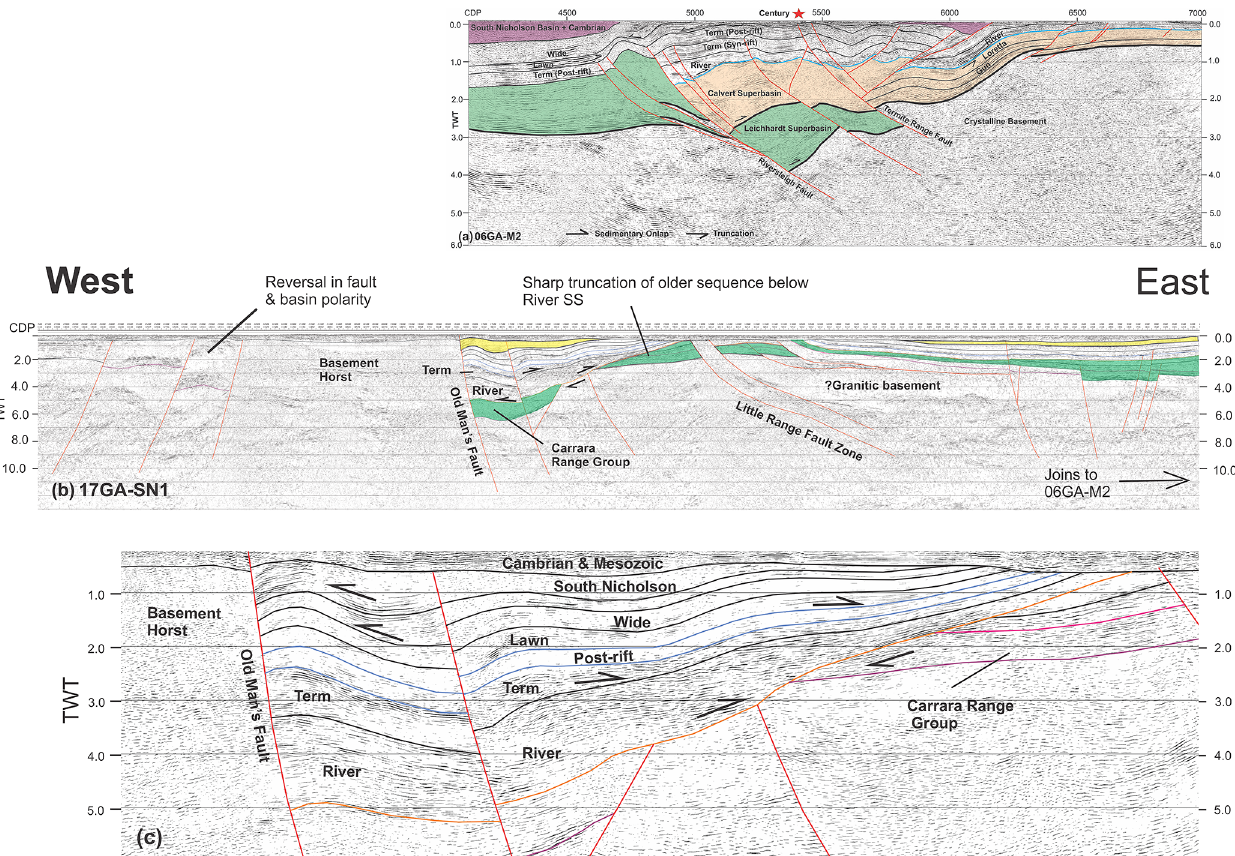
Figure 8. West–east-oriented section through (a) Century Mine (06GAM2); (b) its western continuation (17GA–SN1) across the South Nicholson Basin and Carrara Sub-basin (Carr et al., 2019); and (c) enlarged section of 17GA–SN1 showing angular unconformity between the Isa Superbasin and an underlying, variably truncated older basin sequence. This older basin sequence directly overlies crystalline basement and likely comprises rocks of the Leichhardt Superbasin, correlatives of which (Carrara Range Group) are exposed in the Carrara Range immediately to the north of seismic line 17GA–SN1 (see Fig. 4). Note also that this older sequence is contiguous with rocks in the Century region (06GA-M2) previously identified as part of the Leichhardt Superbasin (Gibson et al., 2017). Conversely, the Calvert Superbasin is missing west of the Riversleigh Fault consistent with non-deposition or a period of uplift and erosion during the course of which it and a significant amount of the underlying Leichhardt Superbasin were removed from the geological record. Note that only a portion of line 17GA-SN1 is presented and interpreted here (cf. Carr et al., 2019, who present an interpretation of the full